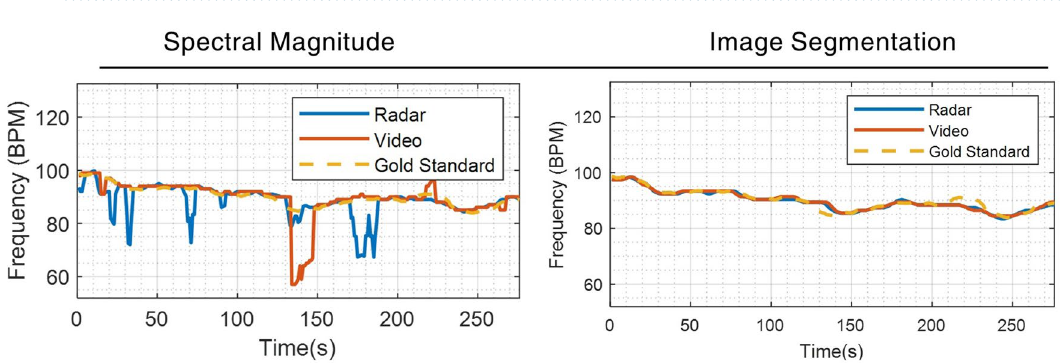
Figure 7. The 5-min HR estimations. Left: the largest spectral magnitude method against the gold standard ECG device reading. Right: the graph-based image segmentation method against the gold standard ECG device